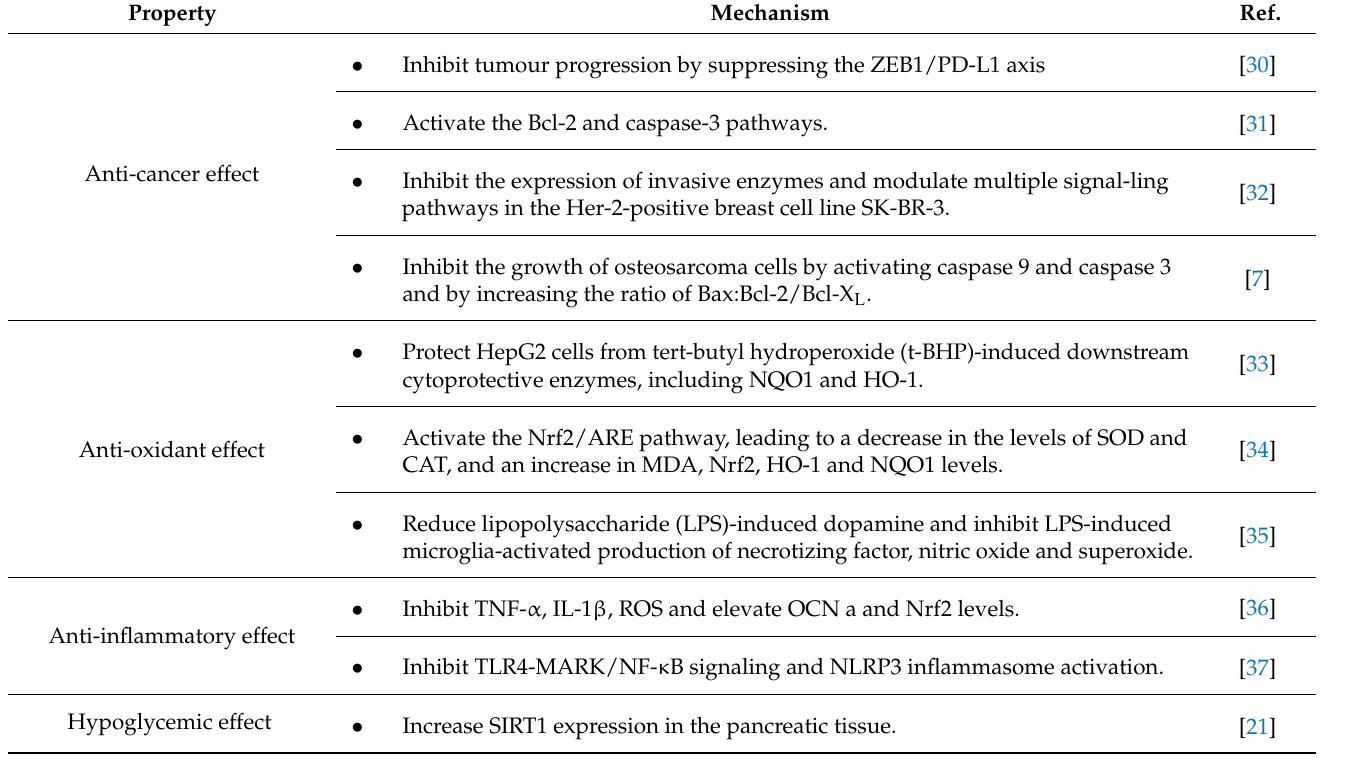
Table 1. The properties of BCA and their mechanisms of